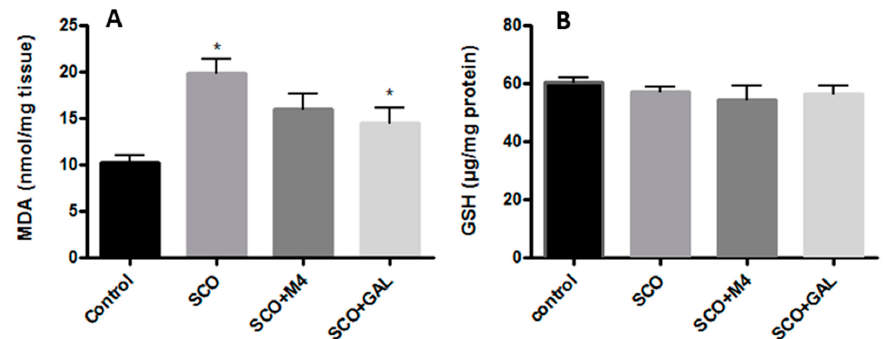
Figure 6. Oxidative stress effects of scopolamine and the M4 compound administered intraperitoneally on malondialdehyde (MDA) and glutathione (GSH). ( A ) MDA levels from samples of the hippocampus tissue of rats without treatment (saline solution; control), treated with scopolamine and scopolamine with M4 compound or scopolamine and galantamine, where